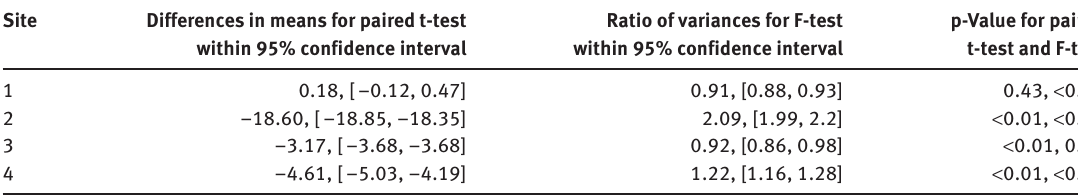
Table 7: Comparisons of Differences between Means and Variances Using Paired t-Test and F-test, p-Value with 95% Confidence Level at Different Sites for Cars (C2) and Long Trucks and Buses